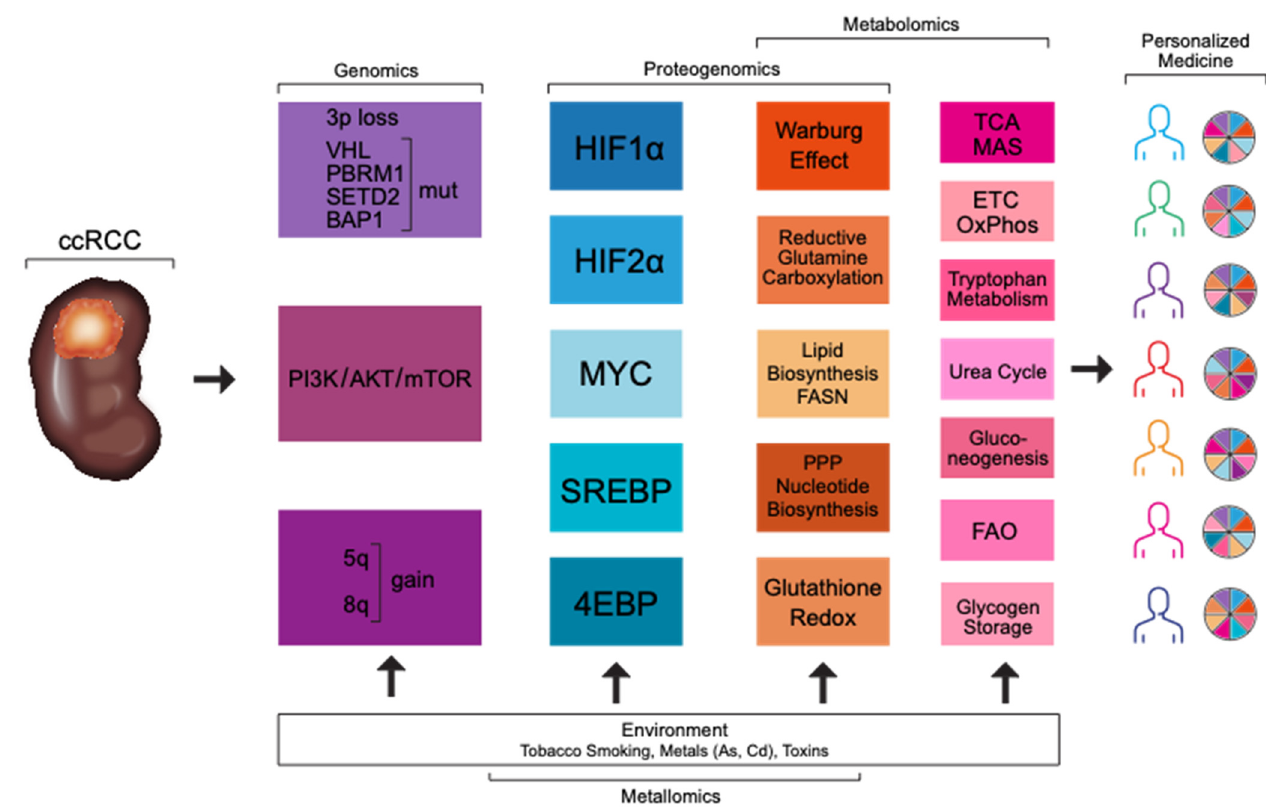
Figure 1. Multiple omics platforms and exposures to the environmental factors are necessary for the identification of ccRCC subtypes with advantages for personalized medicine.